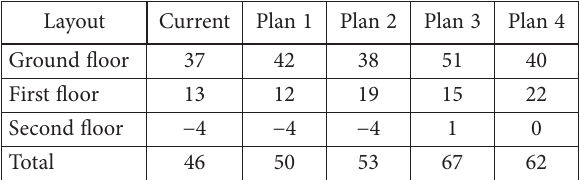
Table 7. Overall interdepartmental relationship